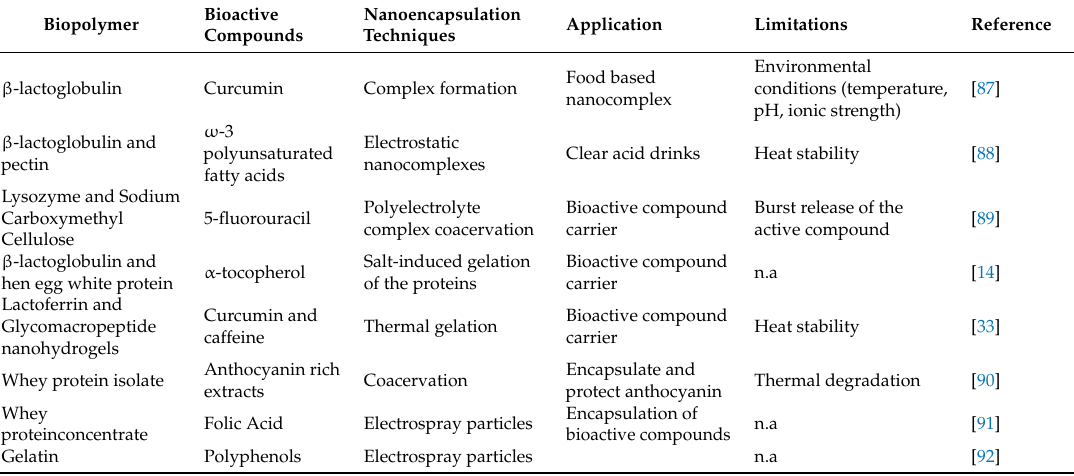
Table 3. Selected bioactive compound-loaded nanohydrogels for food/oral